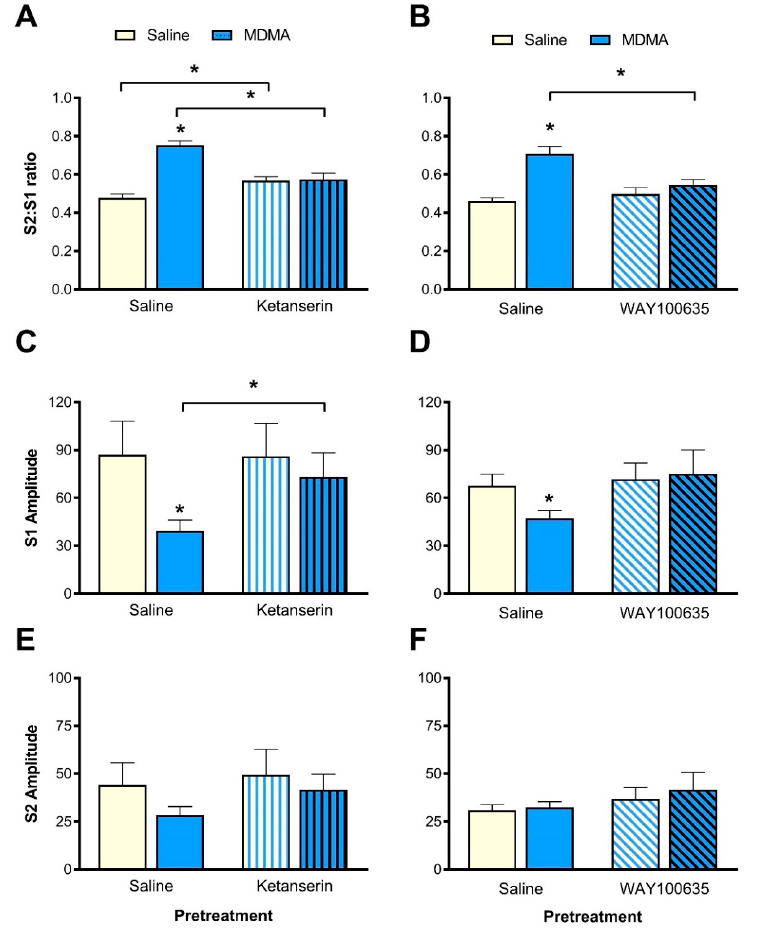
Figure 4. Effect of ketanserin ( A , C , E ) or WAY100635 ( B , D , F ) on MDMA-induced disruption of auditory sensory gating. ( A , B ) MDMA increased the S2:S1 ratio, an effect which was blocked by both ketanserin and WAY100635 pretreatment, respectively. ( C , D ) MDMA treatment reduced the S1 amplitude and this effect was blocked by pretreatment with ketanserin or WAY100635, respectively. ( E , F ) S2 amplitudes remained unaffected by MDMA, ketanserin or WAY100635. Data are mean ± standard error of the mean (SEM). * denotes significance at p < 0.05. N = 13 and 12, respectively.